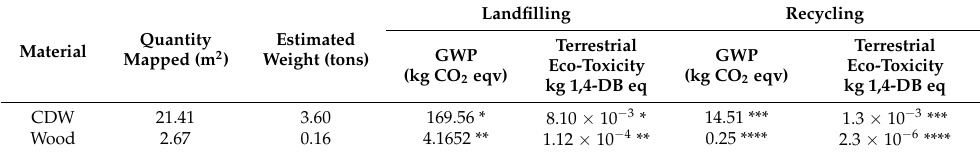
Table 4. Impacts of recycling compared to landfilling on the GWP and toxicity for site